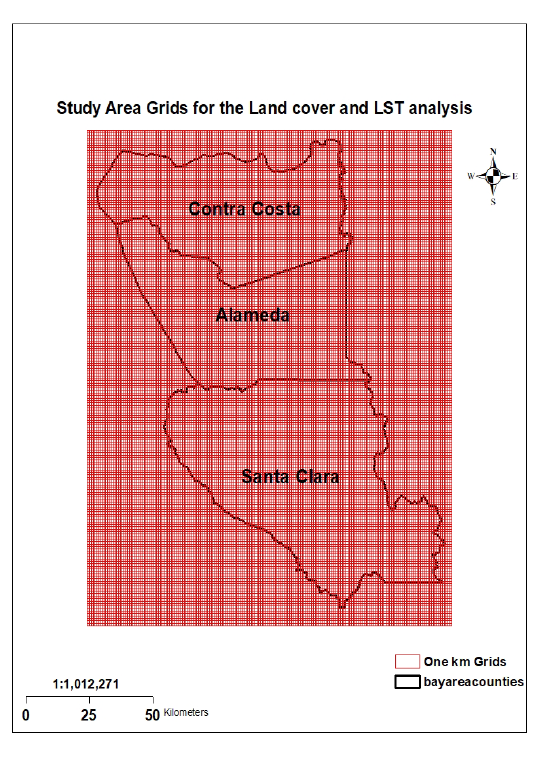
Figure 2. Grids used for the analysis